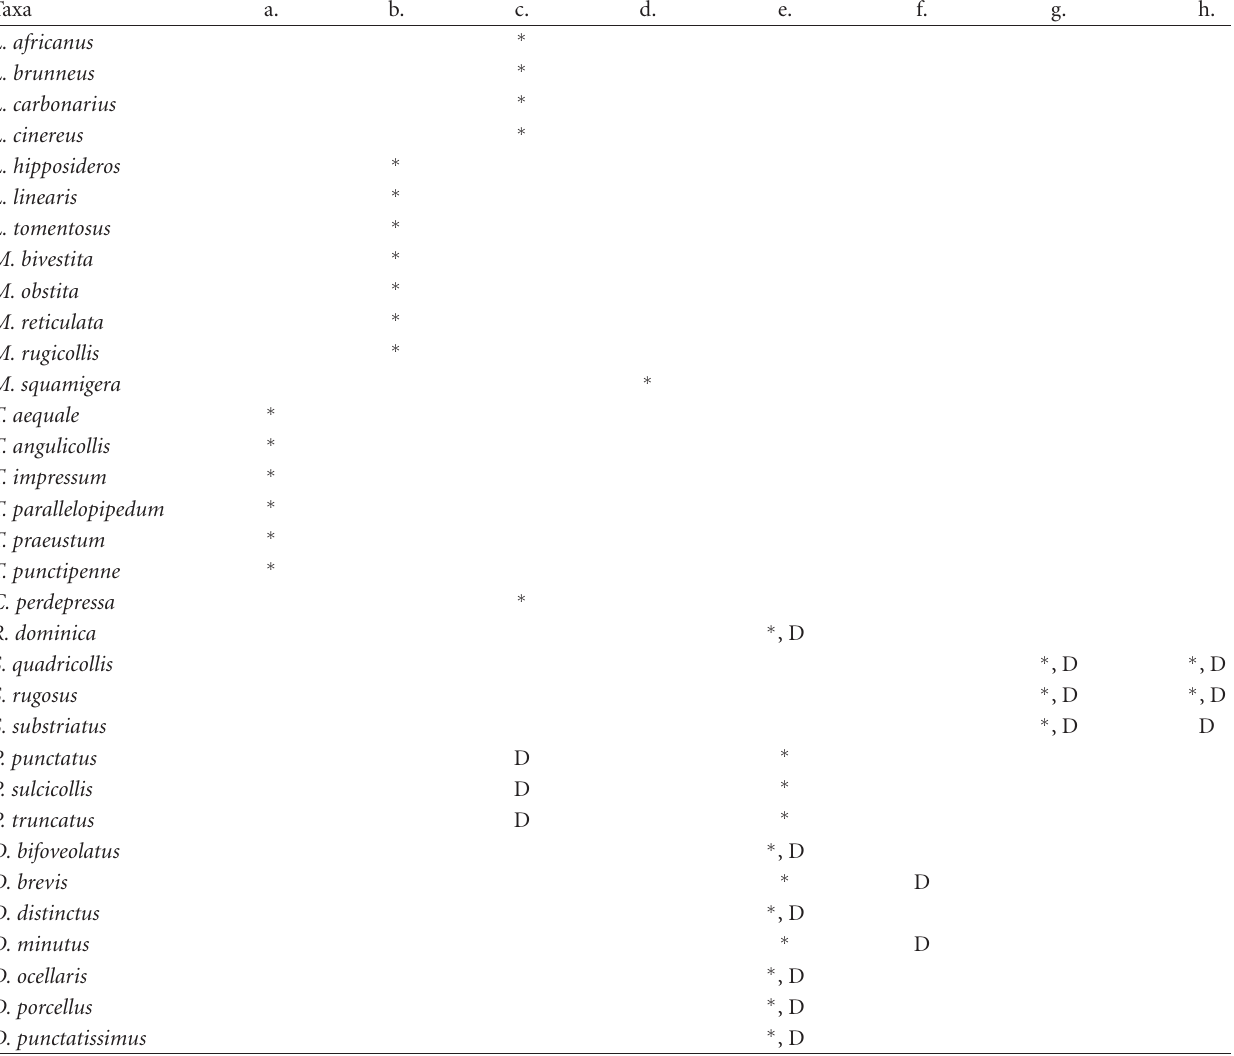
Table 1: Distribution of the di ff erent types of microsculpture ( ∗ : appear on elytra, D: appear on decilivity). Taxa a. b. c. d. e. f. g. h.